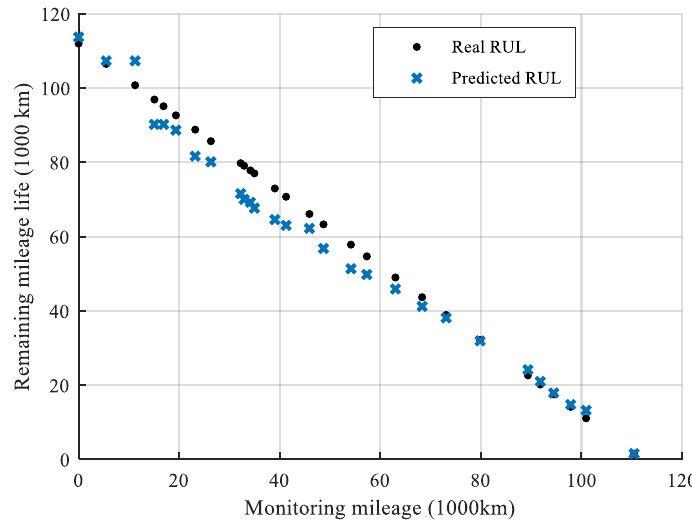
Figure 17. The expectation of RUL prediction and real RUL.